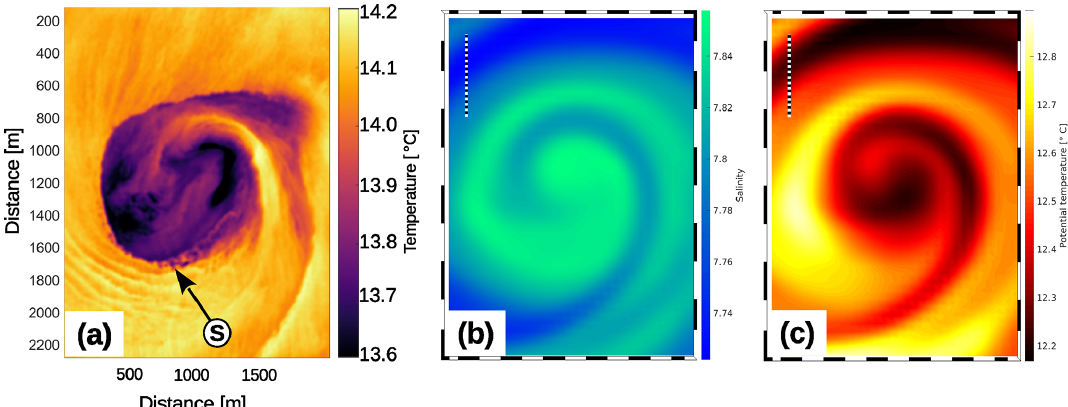
Figure 18. Tracer patterns of submesoscale eddies. (a) Observed sea surface temperature of a cyclonic eddy in the Southern California Countercurrent. The image was taken on 1 February 2013 at 20:34 in the framework of SubEx (Marmorino et al., 2018). (b) Modelled salinity and (c) potential temperature of the cyclone C3 on 26 June at 15m of depth (see Figs. 11 and 12). Cold water spots in (a) are denoted by “S”. The dashed rulers in (b) and (c) represent a distance of